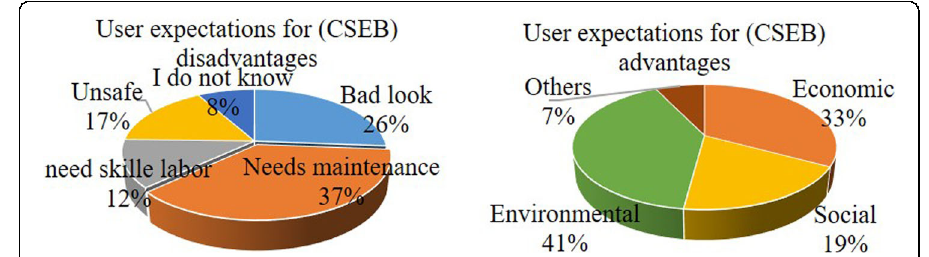
Fig. 8 User expectation for (CSEB) advantages / disadvantages